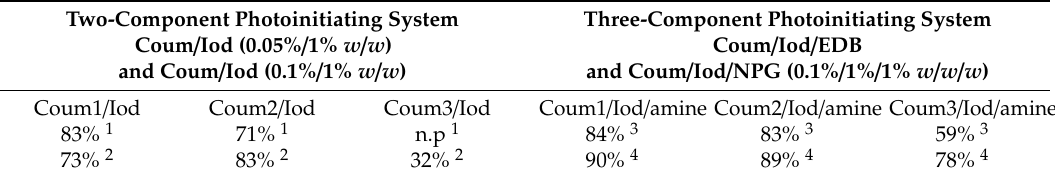
Table 1. Final conversions of the acrylate function for TA using di ff erent PIS (400 s of irradiation, LED @ 405 nm, sample thickness = 1.4